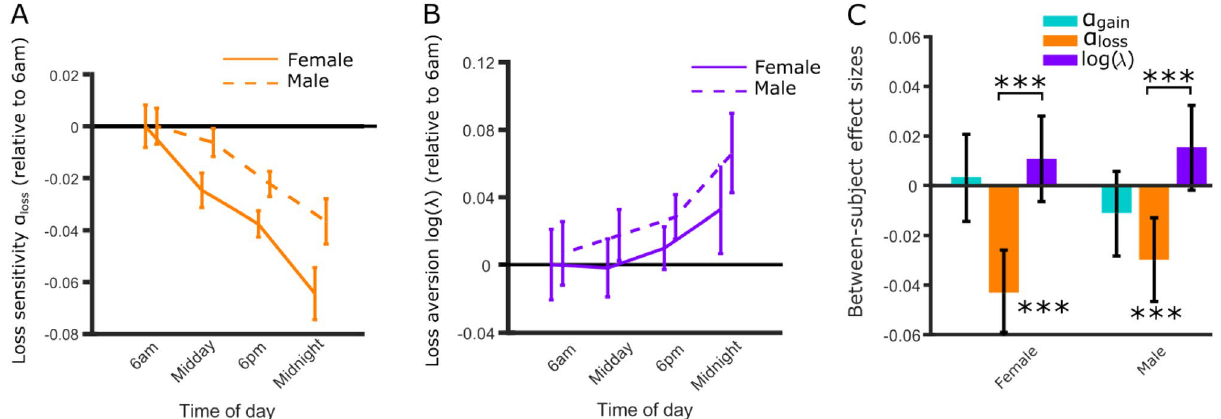
Figure 4. Loss sensitivity and not loss aversion decreases with time of day. ( A ) Loss sensitivity parameters (α loss ) decreased with time of day in both females and males, consistent with increased risk taking in trials with potential losses. Error bars represent the SEM. ( B ) Increased risk taking for losses could be partially explained by decreased loss aversion. However, loss aversion parameters (log(λ)) did not decrease with time of day in both samples. Error bars represent SEM. ( C ) Loss sensitivity decreased more than loss aversion in both females and males. Error bars represent bootstrapped 95% confidence intervals [* p < 0.05, ** p < 0.01, *** p <